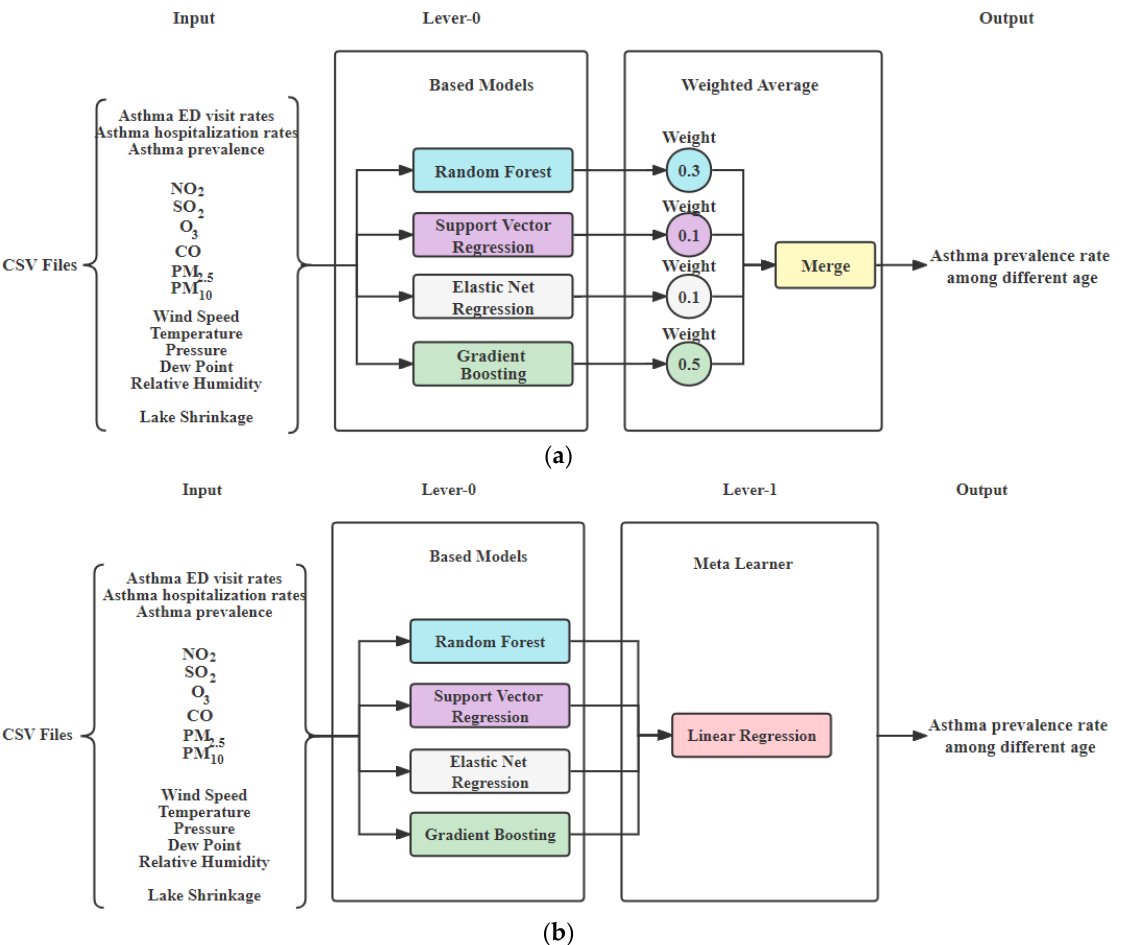
Figure 4. Asthma prediction models: ( a ) ensemble models of weighted average method; ( b ) stacked ensemble model with linear regression (created by author).